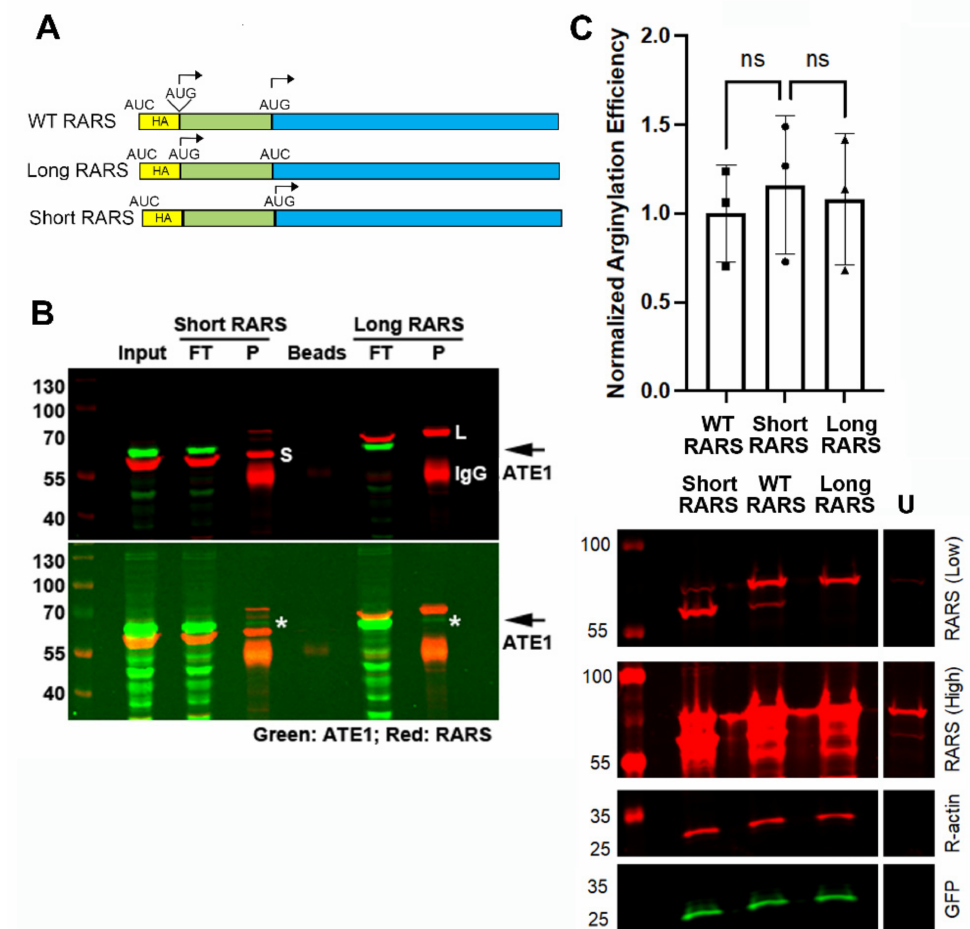
Figure 3. ATE1 can interact with the long and short RARS, but overexpression of RARS does not facilitate arginylation. ( A ) Schematic representation of the RARS constructs used for immunoprecipi- tation and overexpression. Start codons (AUG) were individually mutated to AUC to abolish the HA tag from the expression construct and ensure the start of translation either on both sites (WT) or on the upstream or downstream AUG individually (for the long and short RARS, respectively). ( B ) Representative immunoblots of the immunoprecipitation steps from HEK293T cells transfected with either the short or long RARS as indicated on the top and visualized with RARS and ATE1 antibodies. FT, flow-through; P, pulldown. The top and bottom panels show the same blot at different exposures to visualize the typical immunoprecipitation steps (top), as well as the minor levels of ATE1 in the precipitates (bottom, marked with asterisks and arrows on the right). The positions of the short and long RARS are indicated in the top panel as S and L, respectively. IgG, immunoglob- ulin heavy chain. The pulldowns were repeated at least 3 independent times with similar results. ( C ) Chart and representative immunoblots of arginylation sensor quantification in HEK293T cells transfected with different RARS isoforms as indicated. U, untransfected control. High and low exposure images of the same gel are shown to enable a comparison of the levels of endogenous RARS with the transfected RARS isoforms. Error bars represent SD; n = 3 biological replicates. ns, not significant, one-way